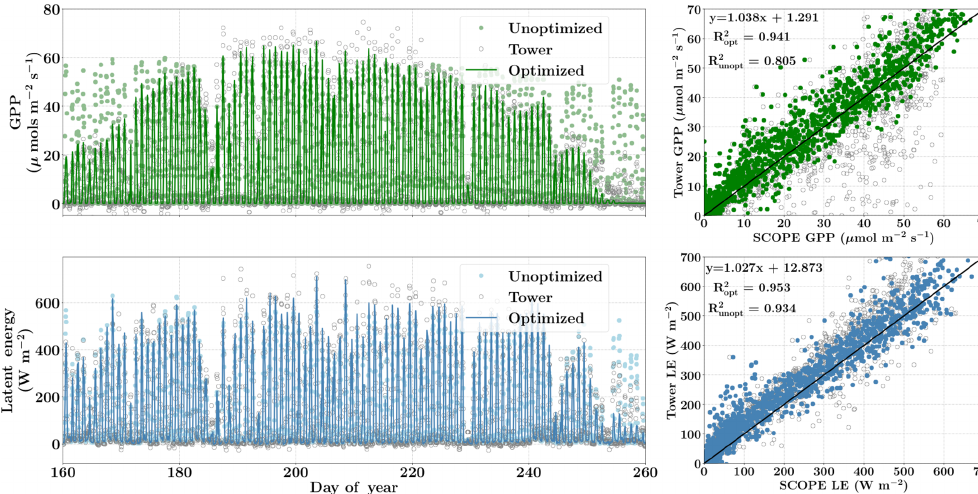
Figure 9. Figure showing the improvement in diurnal and seasonal variability in modeling the GPP and LE fluxes with optimized parameters over prior values using SCOPE for the Nebraska Mead-1 site for the year 2010. The figure also shows the one-to-one comparison (indicated by the black line) with the observed flux tower values. The optimization of the photosynthetic parameters improves the accuracy of computing the carbon and water fluxes as indicated by the R 2 value and the equation of the regression line.